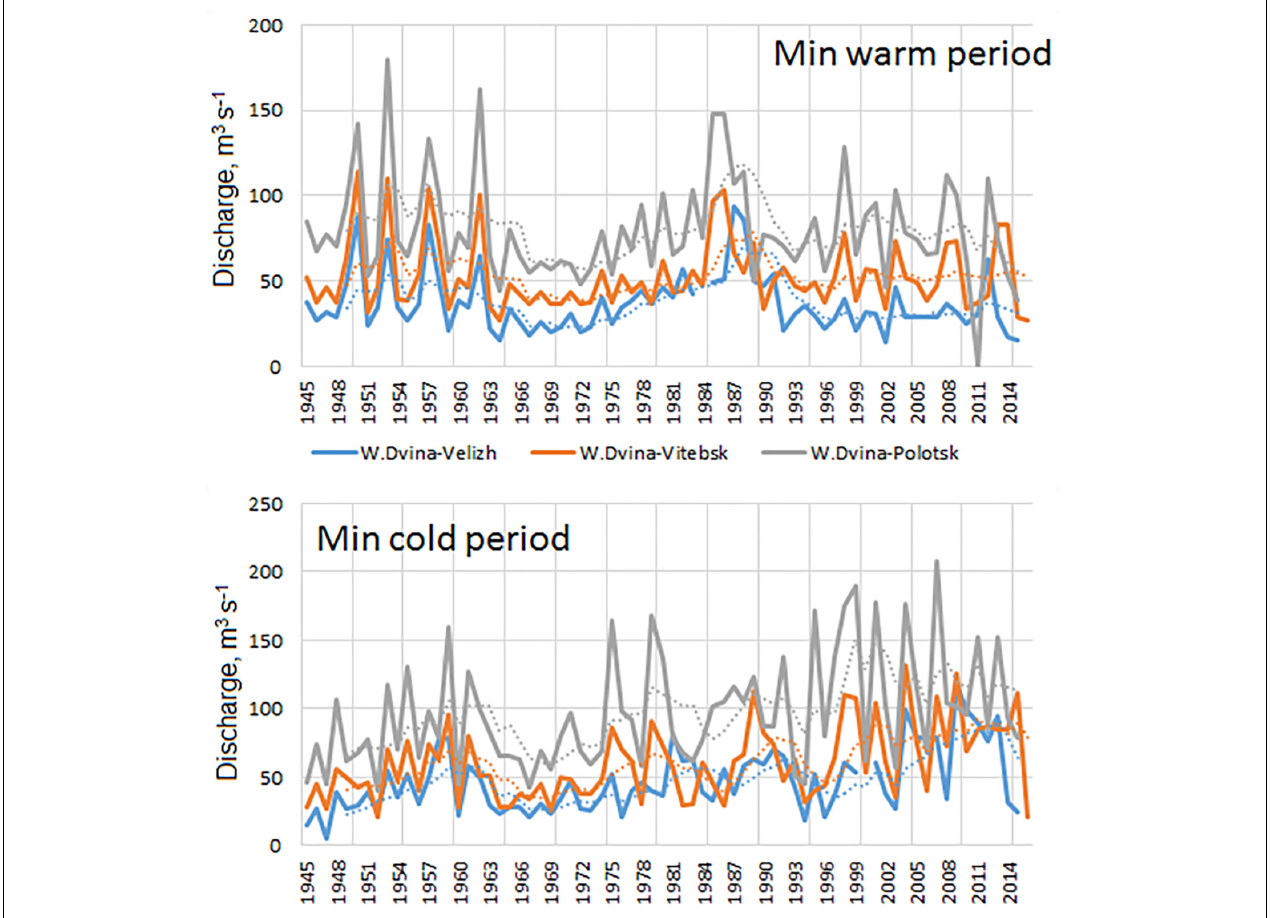
FIGURE 10 | The dynamics of low-flow annual discharges in the Western Dvina River in warm and cold seasons (solid lines) and smoothed by 5-year filter (dotted lines).